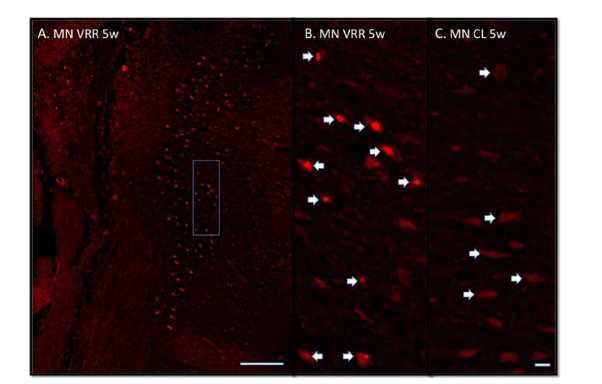
FIGURE 3 | (A,B) Immunofluorescence photomicrographs stained with ATF3 antibodies showing spinal motoneurons (MN) after ventral root avulsion followed by direct ventral root replantation (VRR) at 5weeks post-operative survival time. (C) Unlesioned motoneurons located on the corresponding contra-lateral side (CL). A shows a longitudinal section of the lesion side from the spinal cord segments L5-6.The area depicted in (A) displays the area from which the motoneurons in (B) originate. Arrows indicate motoneurons sectioned in the nuclear plane. Note all the labeled motoneurons in (A,B) . If noVRR is made the large majority of motoneurons will not survive 3weeks. Scale bar 500 μ m (A) and 50 μ m (B,C)